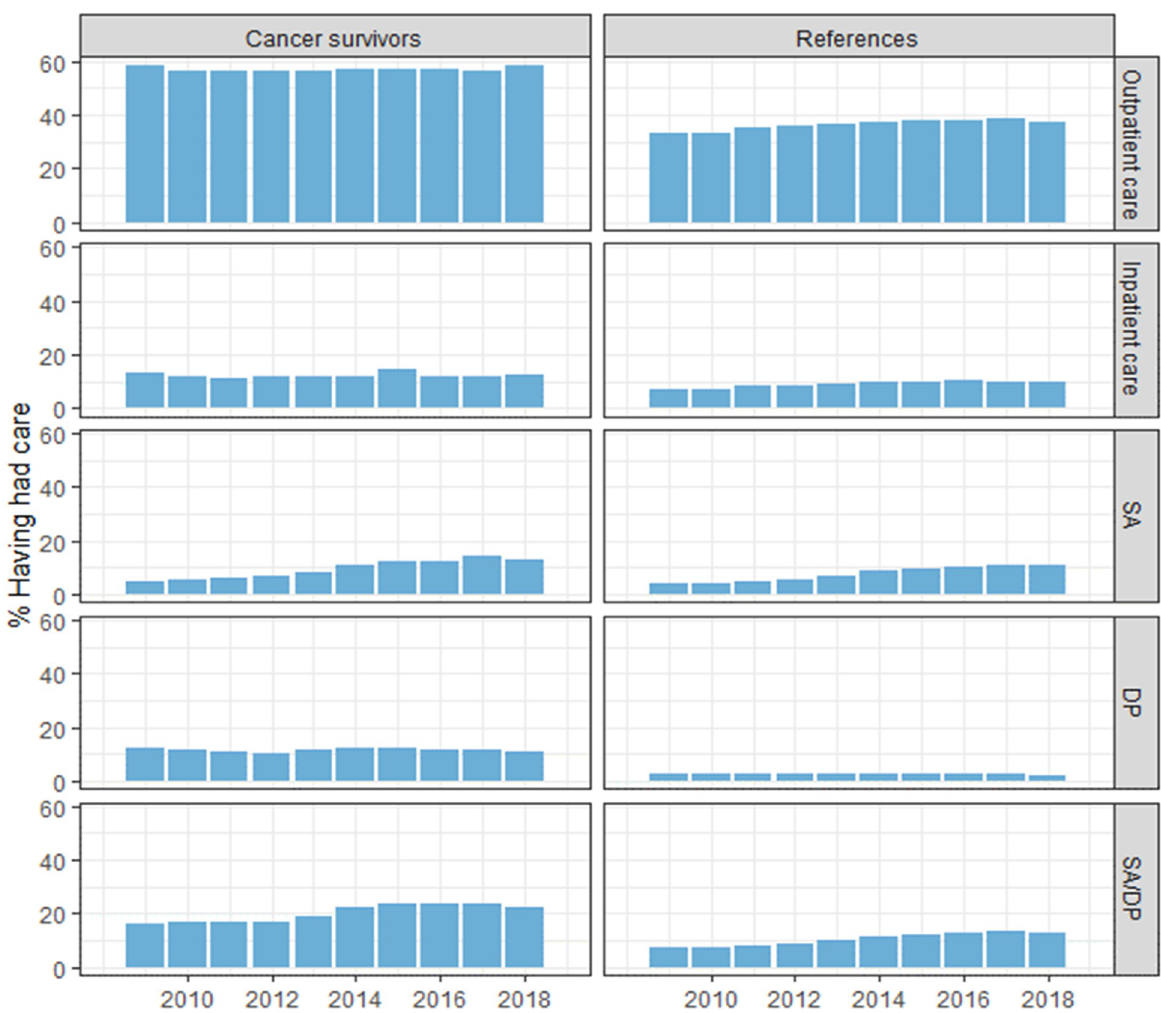
Fig 1. The annual proportions (%) of childhood cancer survivors and matched references who each of the years 2009–2018 had specialized outpatient care, inpatient care, sickness absence (SA), disability pension (DP), and sickness absence and/or disability pension (SA/DP),